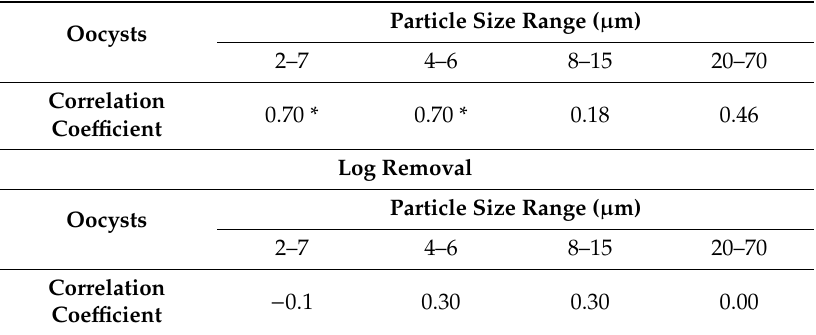
Table 2. Spearman’s correlation coe ffi cients between Cryptosporidium oocysts, particle counts, and their removals (log) at the ripening